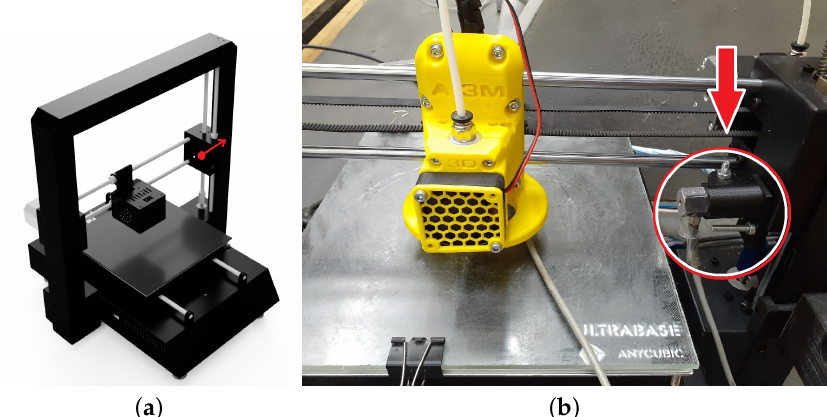
Figure 9. ( a ) Model of the 3D printer Anycubic i3 Mega. A circle marks a place of the accelerometer mounting, an arrow marks the direction of axis sensitivity ( b ) Example of the accelerometer mounting.